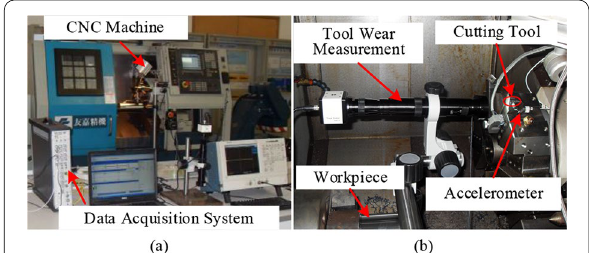
Table 5 MAE of all the models in the first experimental case